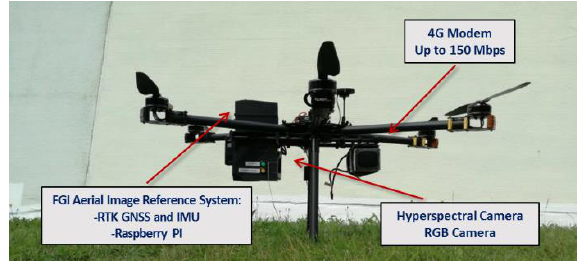
Figure 1. Implementation of the real-time hyperspectral drone system.